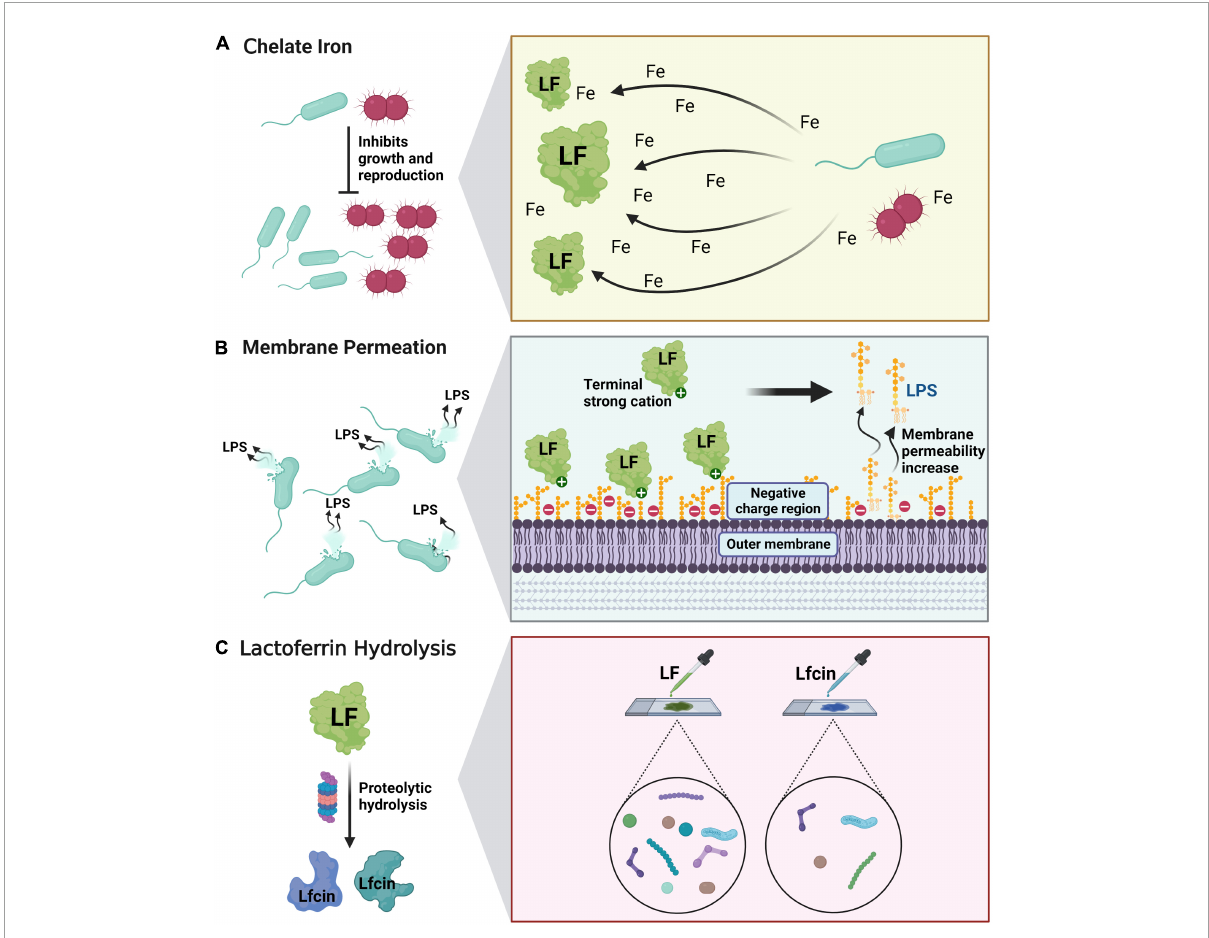
FIGURE3 Antibacterial and bactericidal mechanism of lactoferrin. (A) Lactoferrin acts as an antibacterial agent by chelating free iron-mediated activity. (B) Lactoferrin increases the permeability of bacterial cell membranes through the strong cation-binding region at the amino terminus, producing a direct bactericidal effect. (C) Lf hydrolyzes to obtain antimicrobial peptide, which exerts stronger antimicrobial